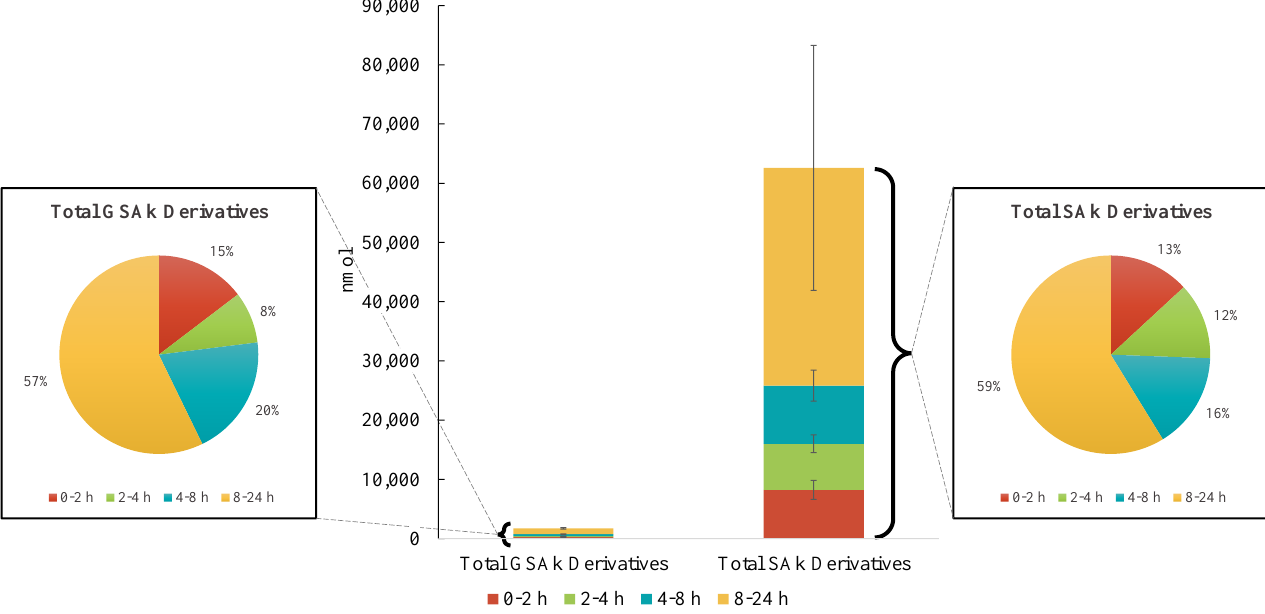
Figure 2. Time-course profiles of the organosulfur compounds identified during the urinary excretion after the intake of black garlic. GSAk: γ-Glutamyl- S -alk(en)yl-L-cysteine; SAk: S -alk(en)yl-L-cysteine. Among the organosulfur compounds detected in the 24 h urine, N -acetyl- S -allyl- L-cysteine (NASAC), N -acetyl- S -allyl-L-cysteine sulfoxide (NASACS) and N -acetyl- S -(2- carboxypropyl)-L-cysteine (NACPC) are the N -acetylated derivatives of alliin, SAC